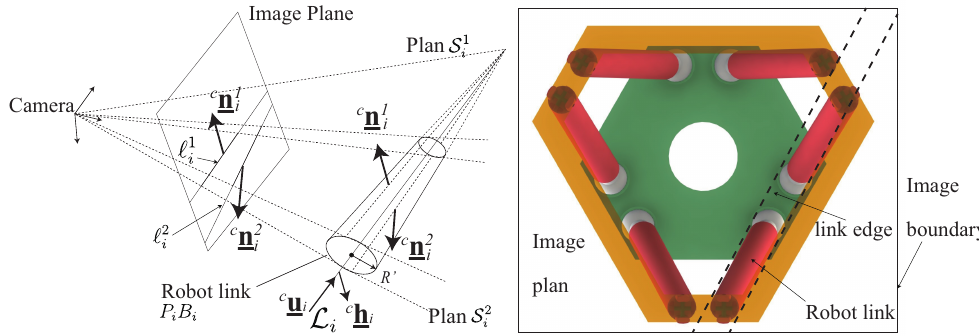
Figure 2. Projection of a cylinder in the image plane and the image from the camera